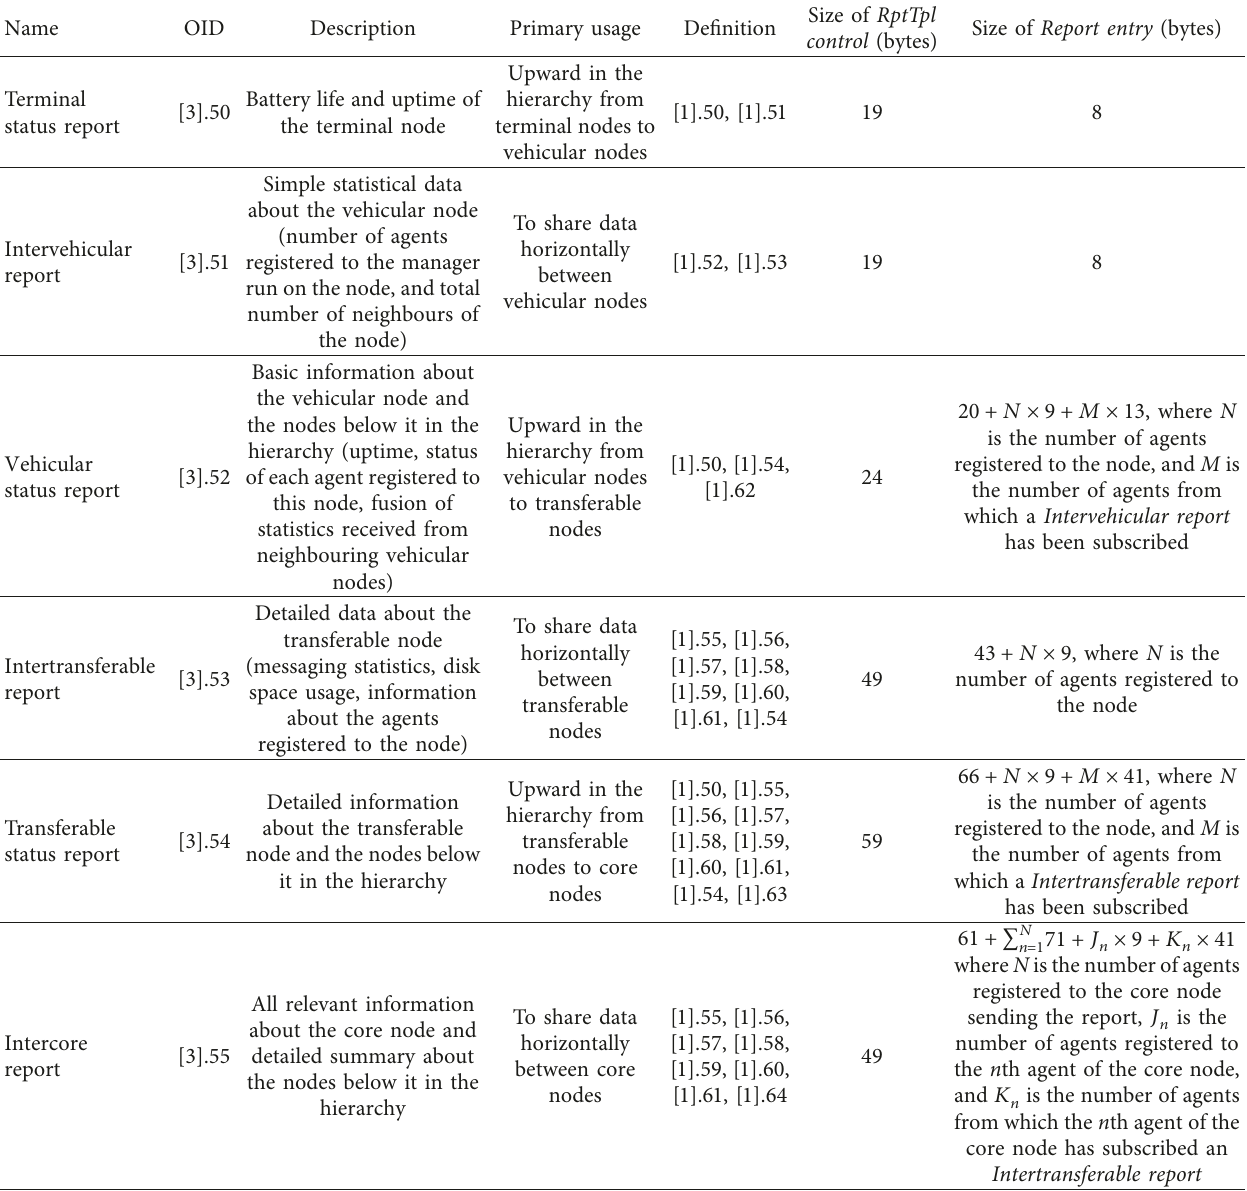
Table 4: AMP Agent Hierarchical Management Data (HMD) Report